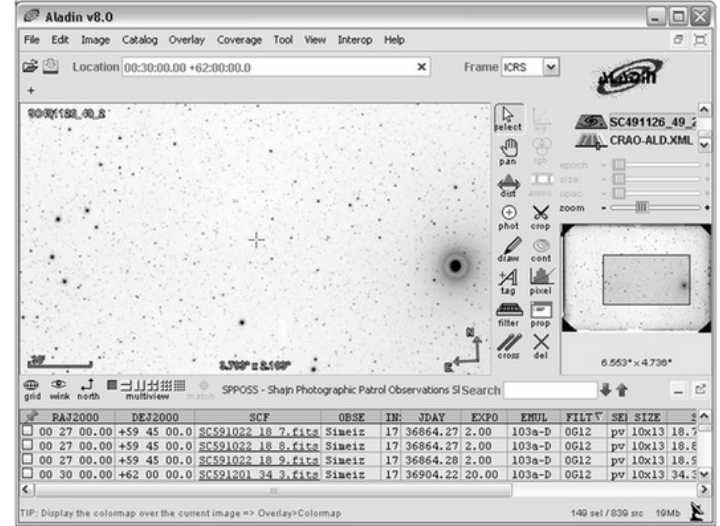
Fig. 2. Example of using the Aladin IVO application for work with the DBO, for photographs obtained within the project “G. A. Shajn’s